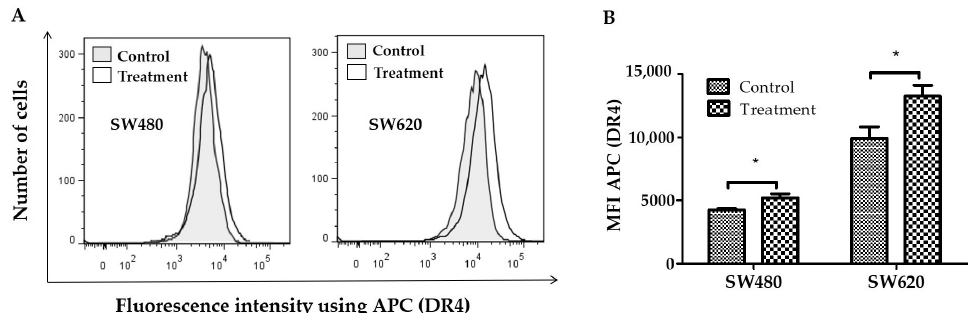
Figure 4. Effect of LMPE on DR4 death receptor expression in SW480 and SW620 cell lines. Histograms represent fluorescence intensity using anti-DR4-APC (detected by flow cytometry) on SW480 and SW620 cells ( A ). DR4 death receptor expression is indicated by the mean fluorescence intensity (MFI) of APC in SW480 and SW620 ( B ) cells. Cells were exposed to 30 mg LMPE/mL for 48 h. Untreated cells (0 mg LMPE/mL) were used as a control. Data were expressed as mean ± SEM ( n = 3). The differences between the control and treated cells were analyzed with the Student’s t test. The significant differences were expressed as * p < 0.05.